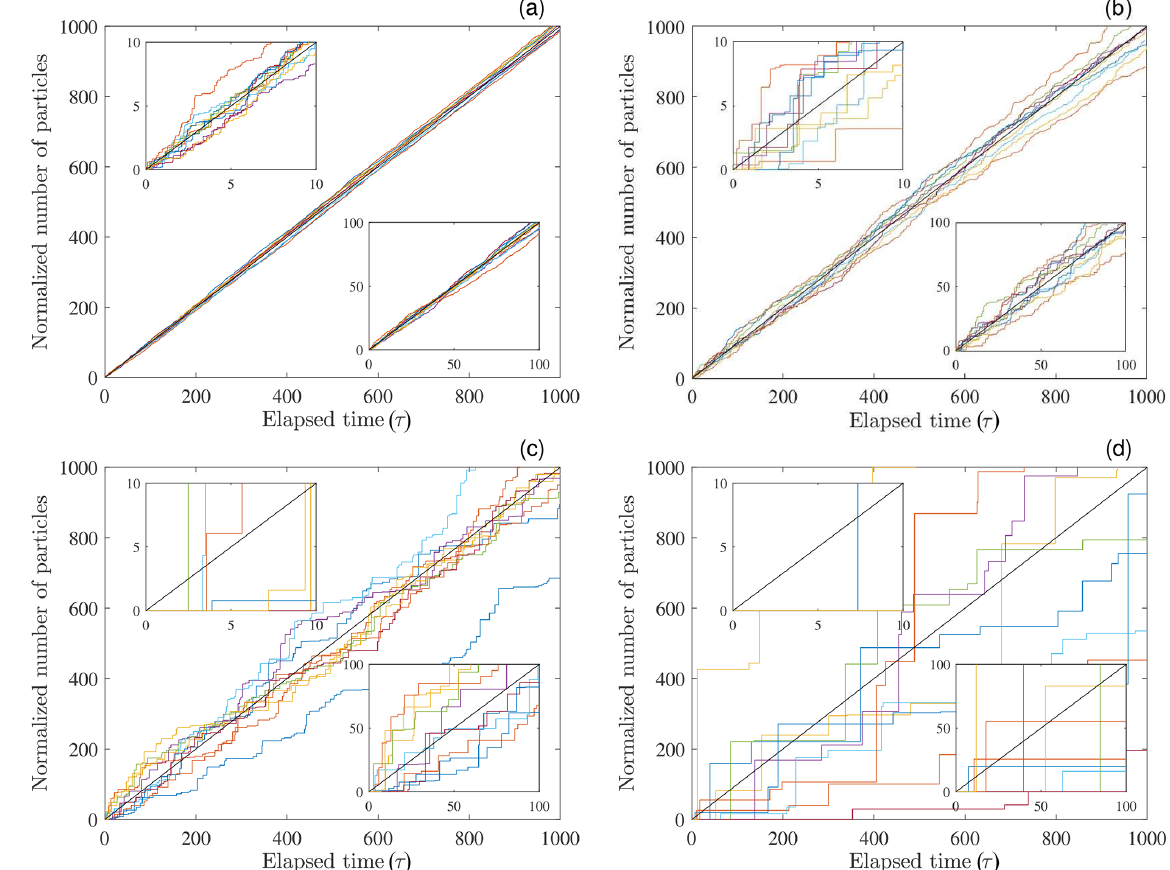
Figure 5. Plot of 10 realizations of normalized number ˆ n ( x ) versus elapsed time τ showing increasing variance with τ . Plots generated with µ n = 1000 and (a) η = 10, (b) η = 1 (c) η = 0 . 1 and (d) η = 0 . 01. Red line represents ensemble expected values of ˆ n ( x